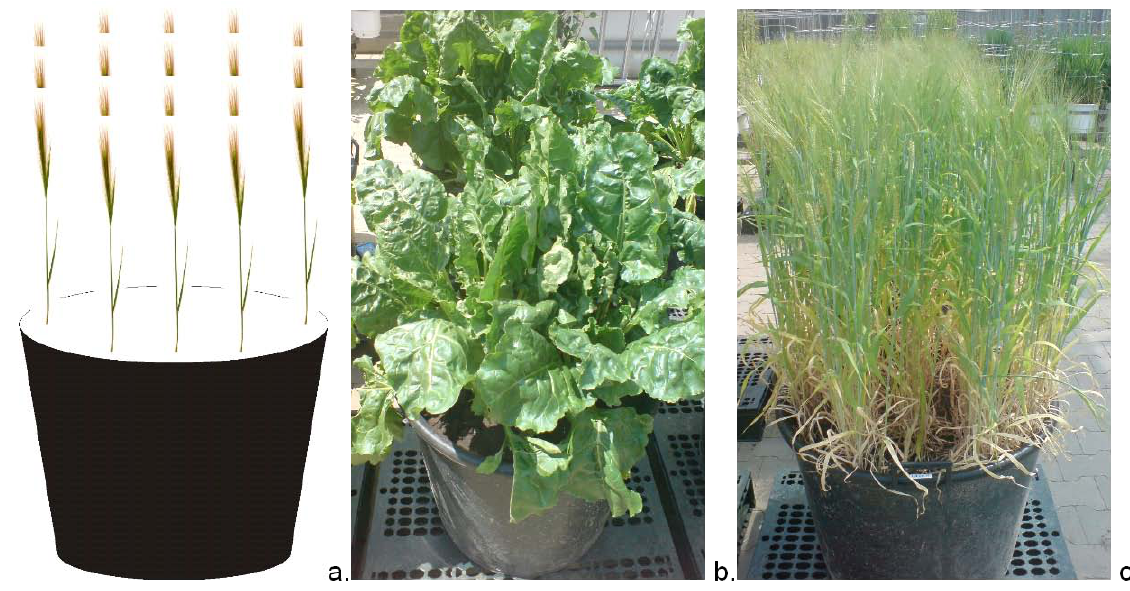
Figure 1. Schematic (a) and example pots for sugar beet (b) and barley (c)